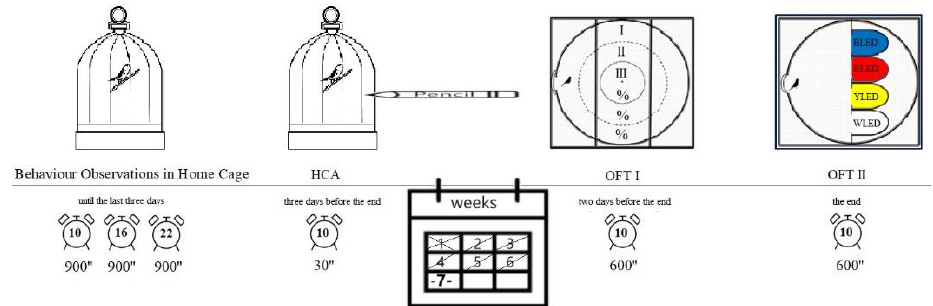
Figure 2. Timeline showing when the behavioural testing occurred during the study.